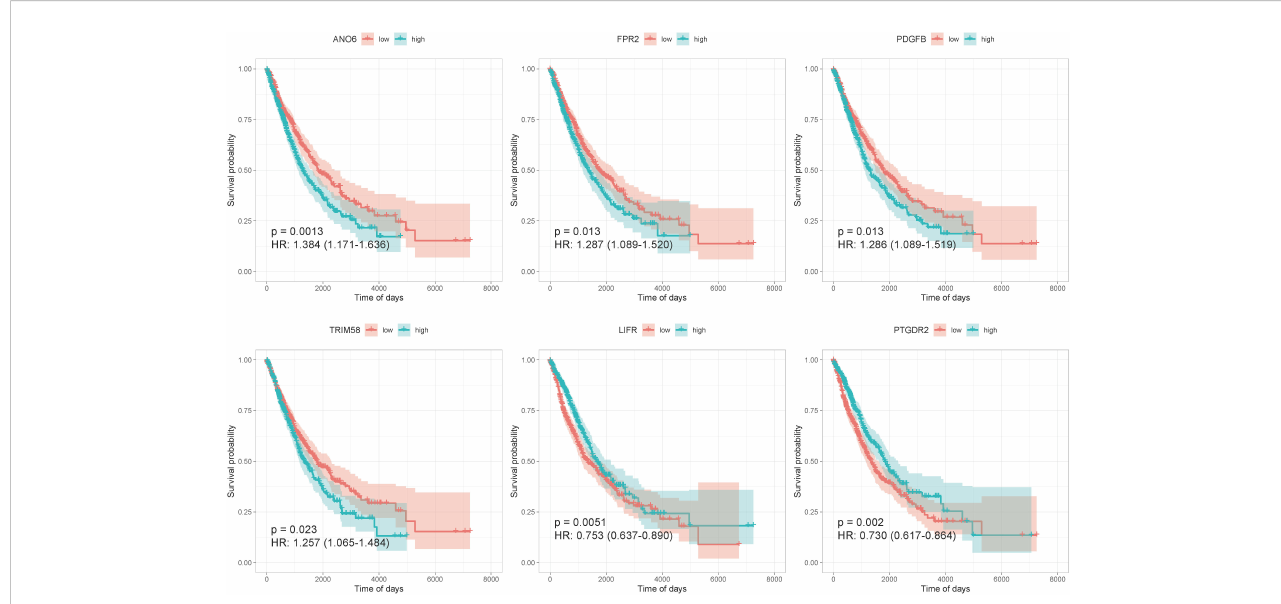
FIGURE 4 The KM survival curves of six prognosis-related genes.